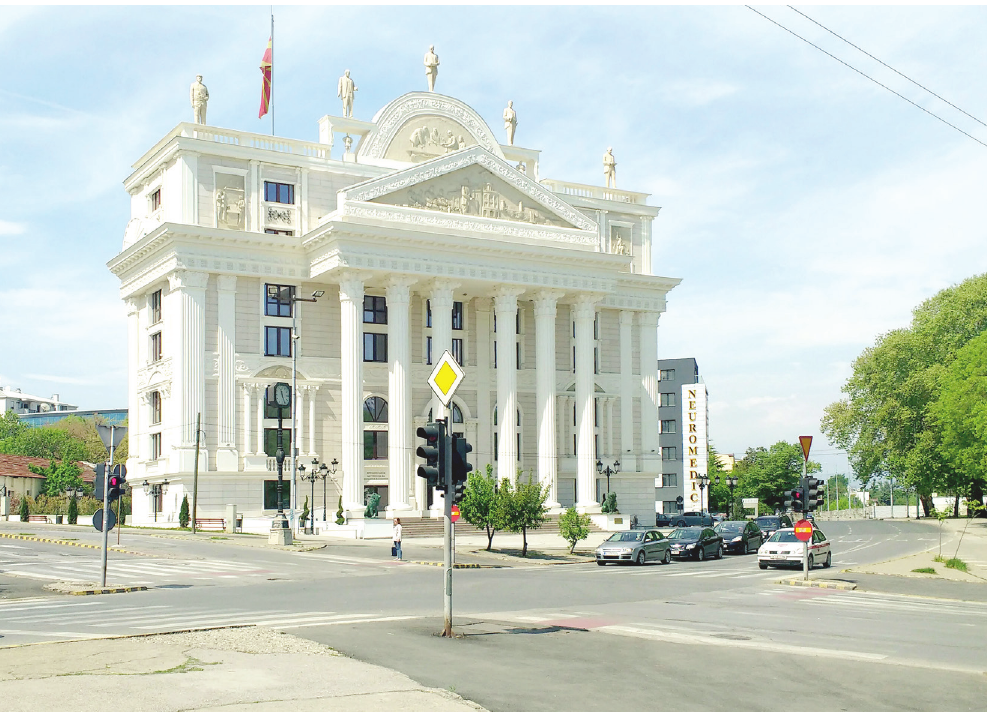
Figure 3 Giuseppe Resta, Skopje 2014 project , 2017, Skopje, Republic of